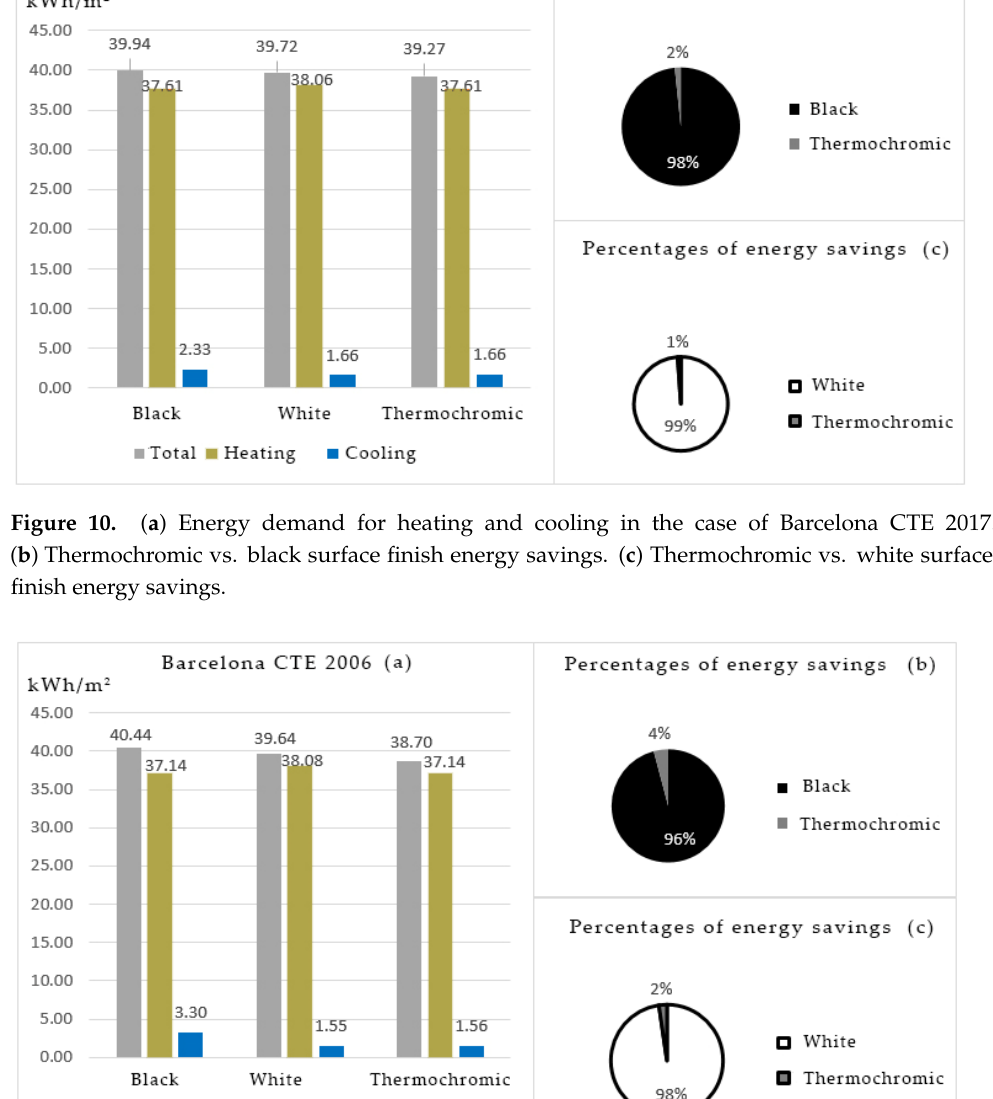
Figure 12. ( a ) Energy demand for heating and cooling in the case of Barcelona NBE-79. ( b ) Thermo- chromic vs. black surface finish energy savings. ( c ) Thermochromic vs. white surface finish energy savings. Therefore, the scope of thermochromic materials can be intuited as having some com- petitiveness in energy rehabilitation for buildings with transmittance values similar to those in NBE-79.